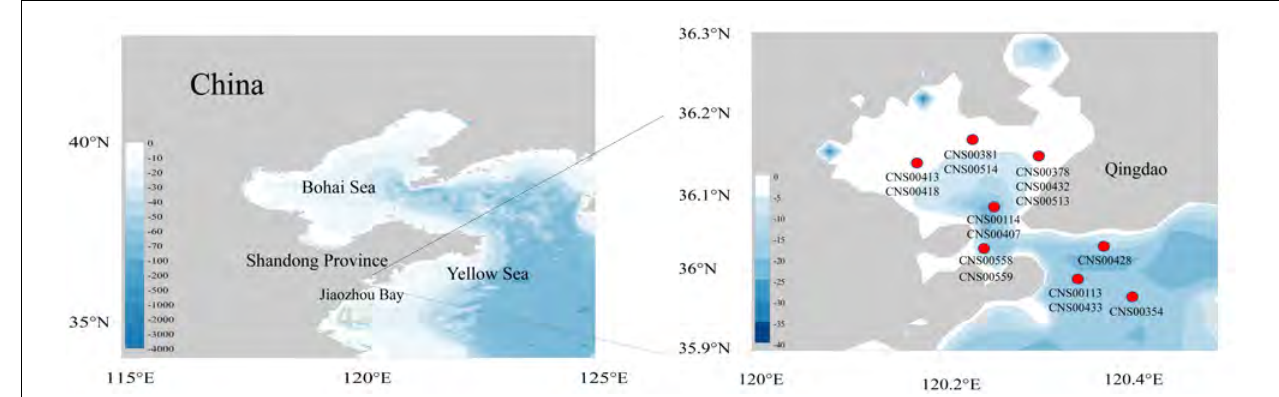
FIGURE 1 | Sampling sites of 15 diatom species in the Jiaozhou